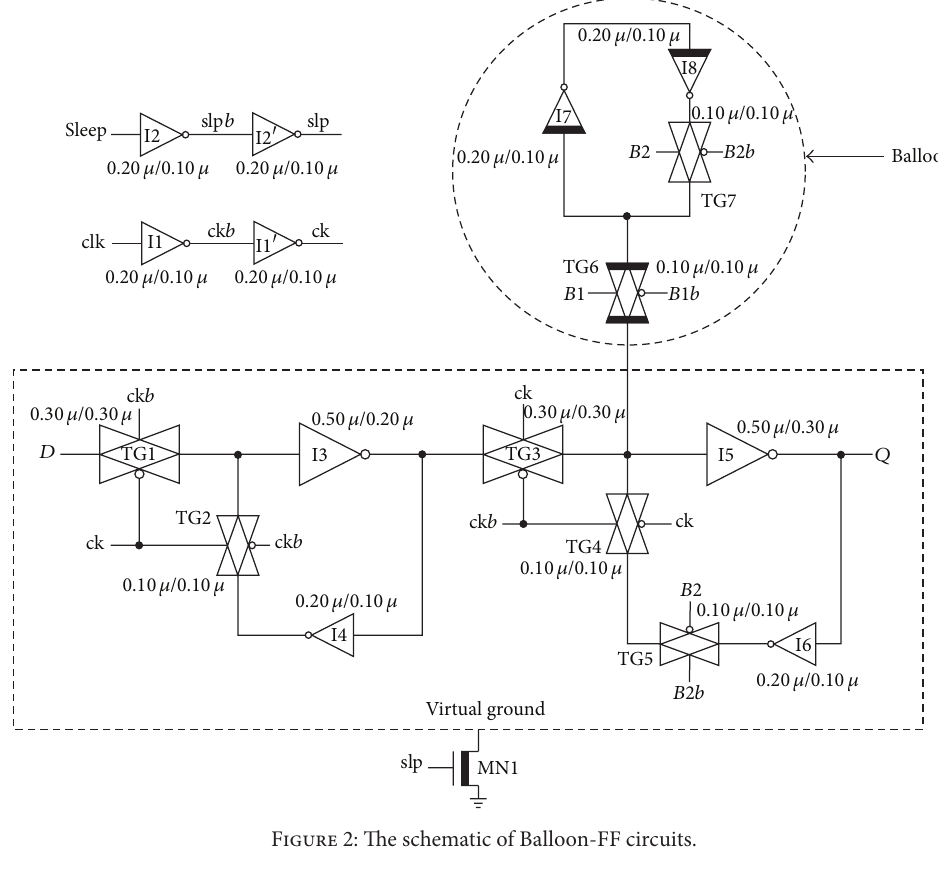
Figure 2: The schematic of Balloon-FF circuits.